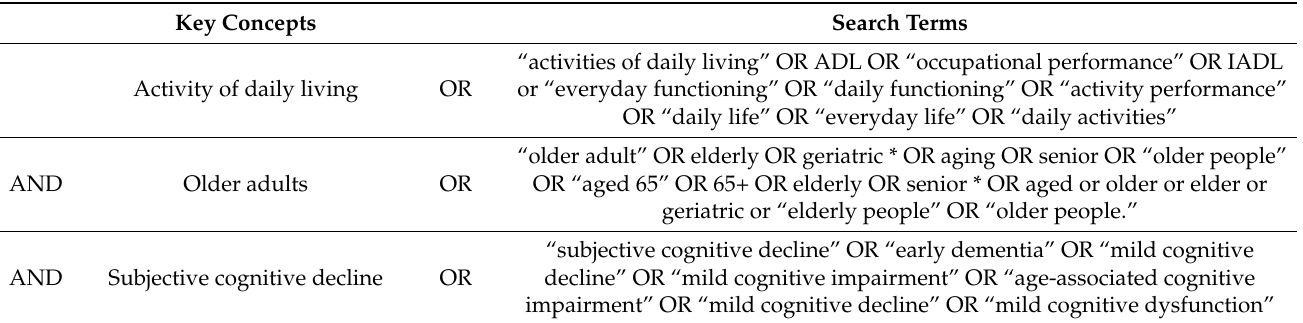
Table 1. Final search strategy on Medline via Ebsco